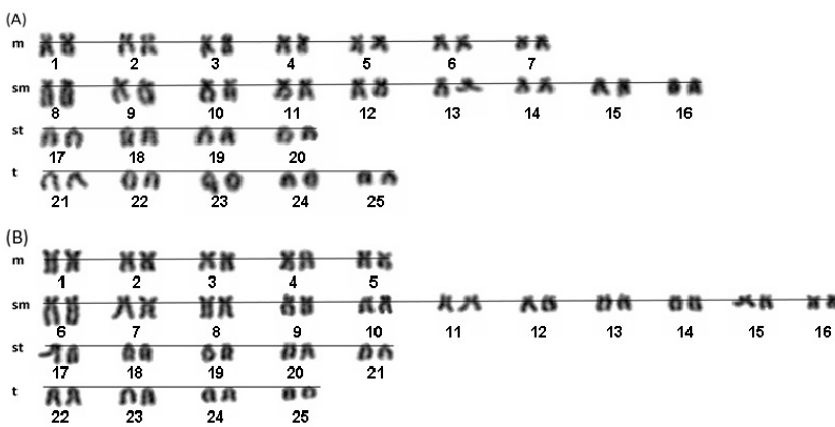
Figure 2. Karyotypes of O. alticorpus ( A ) and O . barbatulum ( B ) females after Giemsa staining. Both species show 2 n = 50; m = metacentric, sm = submetacentric, st = subtelocentric, t = telocentric.